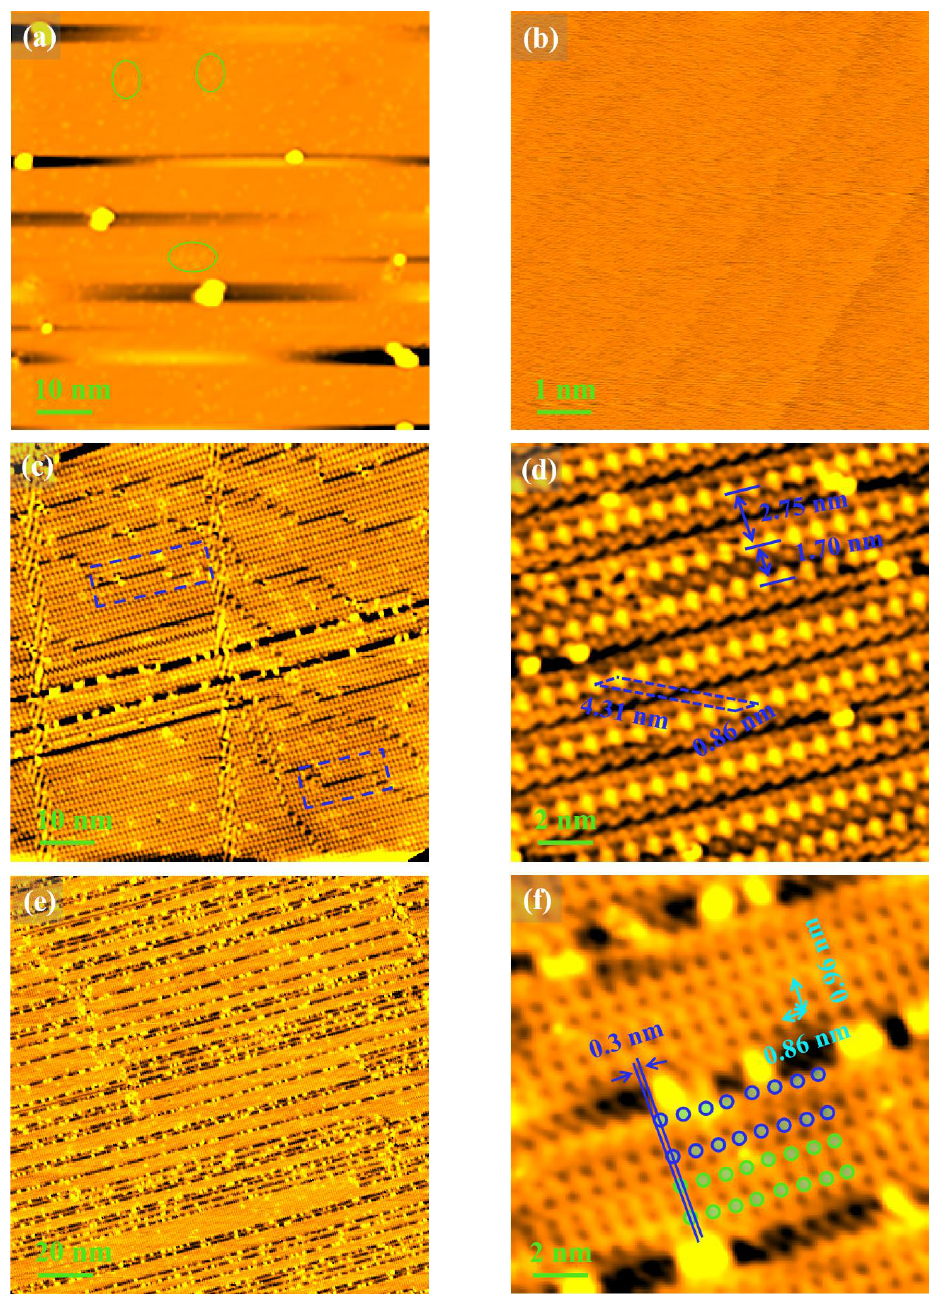
Figure 7. Surface structure from the samples in Process Ⅷ to Process Ⅹ . ( a , c , e ) The STM images (V = 1 V; I = 0.1 nA) of the sample surface after the treatment of Process Ⅷ , Process Ⅸ , and Process Ⅹ , respectively; ( b , d , f ) correspond to the higher-resolution STM images in ( a , c , e ), respectively. The blue and green circles in ( f ) mark the Cu atoms.